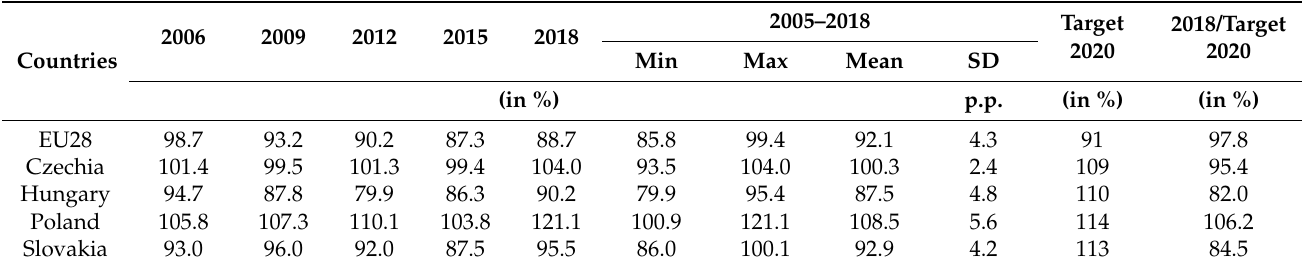
Table 4. Greenhouse gas emissions in effort sharing decision (ESD) sectors in V4 countries in the years 2006–2018 (the base year 2005).